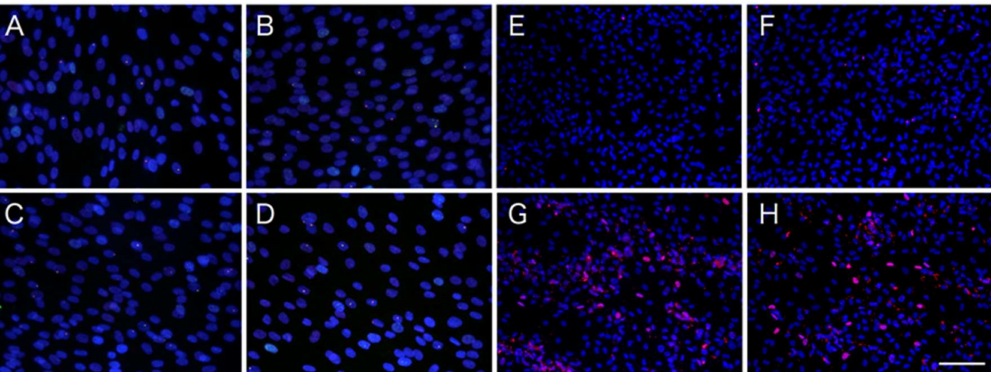
Figure 4. DNA damage and apoptosis induction in ADSCs and during adipogenesis by ATV treatment. ( A – D ) ADSCs, cultured in a serum-free medium, were treated with varying concentrations of ATV for 7 days. ( E – H ) ADSCs, cultured in serum-free medium until they reached confluence, were incubated in adipogenic differentiation medium for 10 days concurrently with varying concentrations of ATV. ( A , E ) control, ( B , F ) 5 µ M ATV, ( C , G ) 10 µ M ATV, and ( D , H ) 20 µ M ATV. Images were taken under a fluorescence microscope. Red fluorescence indicates phosphorylated histone H2AX. White scale bar indicates 125 µ m. Table 1. Apoptosis in differentiating adipocytes by ATV treatment.